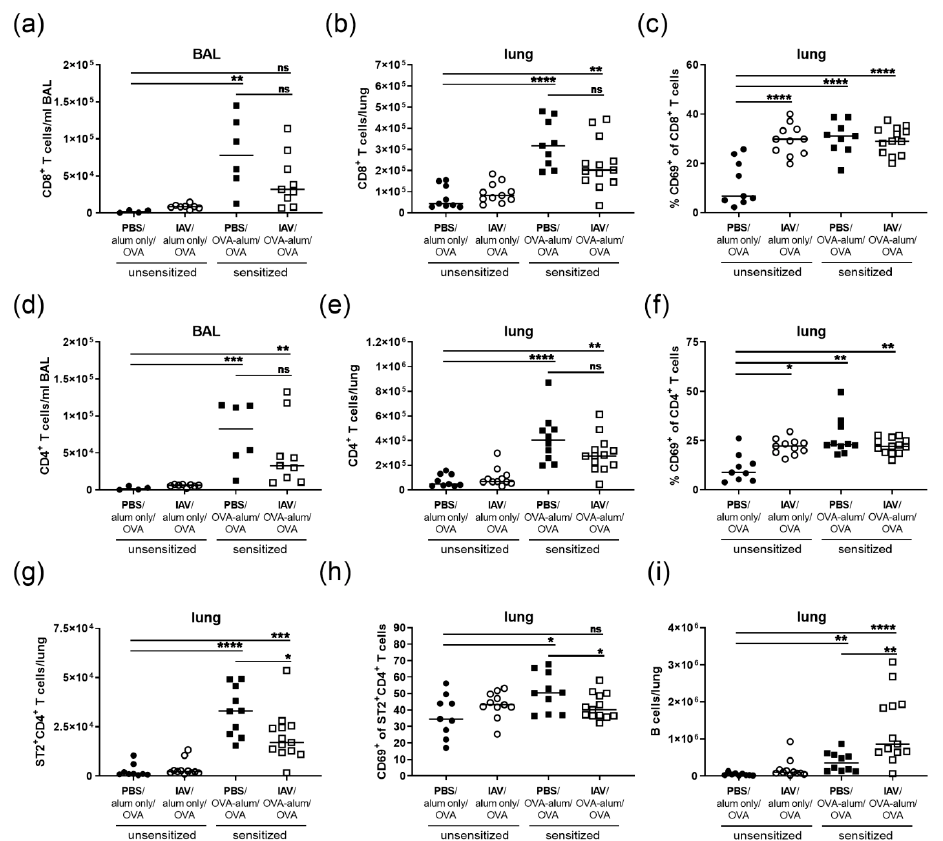
Figure 6. Resolved IAV infection significantly a ff ects lung Th2 cell numbers, Th2 cell activation and B cell numbers in AAI. Mice were infected i.n. with a sublethal dose of IAV or treated with PBS on day 0, were sensitized against OVA i.p or mock-sensitized with alum only i.p. on days 14, 21 and 28 and all mice were challenged i.n. with OVA on days 35, 36 and 37. On day 39 post infection, CD8 + T cell numbers in the BAL ( a ) and lungs ( b ), the frequency of CD69-expressing CD8 + T cells in the lungs ( c ), CD4 + T cell numbers in the BAL ( d ) and lungs ( e ), the frequency of CD69-expressing CD4 + T cells in the lungs ( f ), Th2 cell (ST2 + CD4 + T cells) numbers in the lungs ( g ), the frequency of CD69-expressing Th2 cells in the lung ( h ) and lung B cell numbers ( i ) were flow cytometrically analyzed. Data are shown for individual mice together with the group median. BAL data are compiled from two independent experiments and lung data are compiled from three independent experiments. * p < 0.05, ** p < 0.01, *** p < 0.005, **** p < 0.001, ns = not